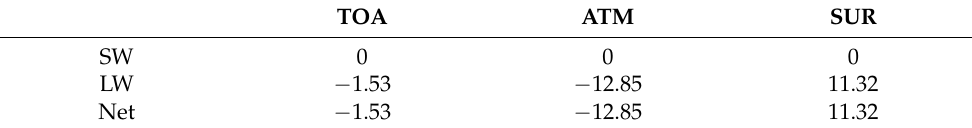
Table 3c . Same as Table 3a, but for the nighttime. Unit: Wm − 2 .